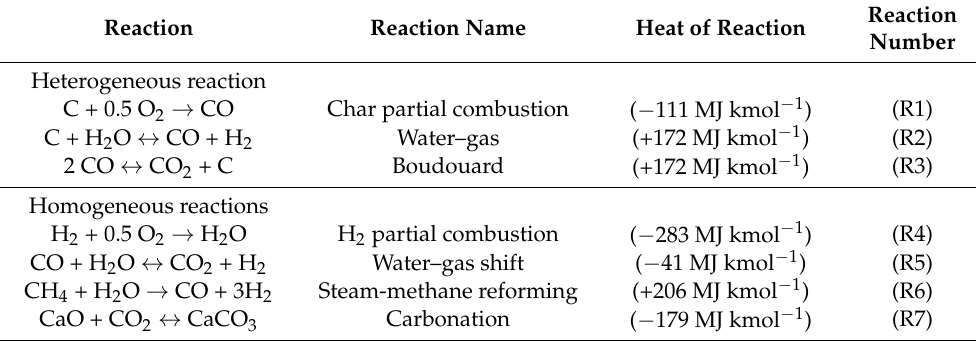
Table 2. Gasification reactions